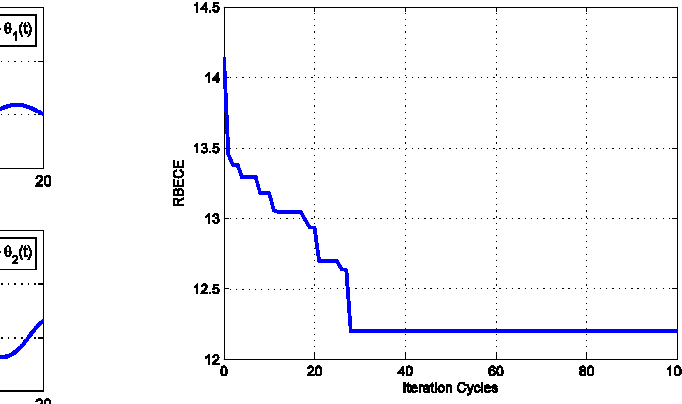
Fig. 14. Convergence history of RBECE function.